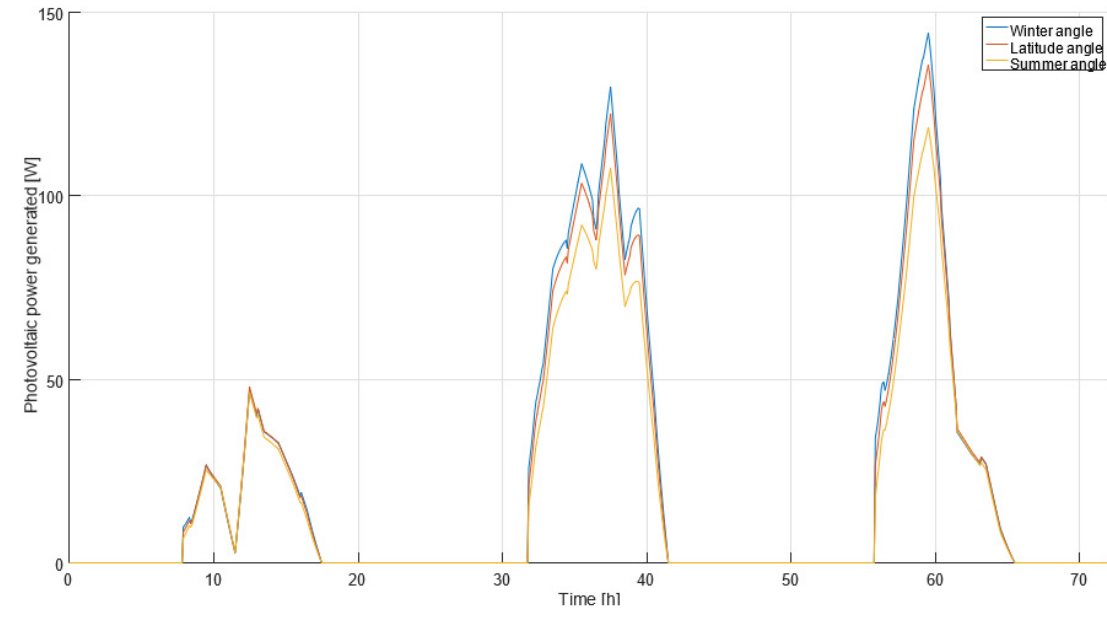
Figure 17. Energy stored in a “virtual” battery for the 3 tilt angles.